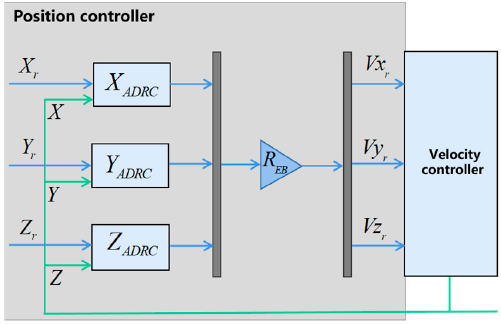
Figure 7. Position controller.